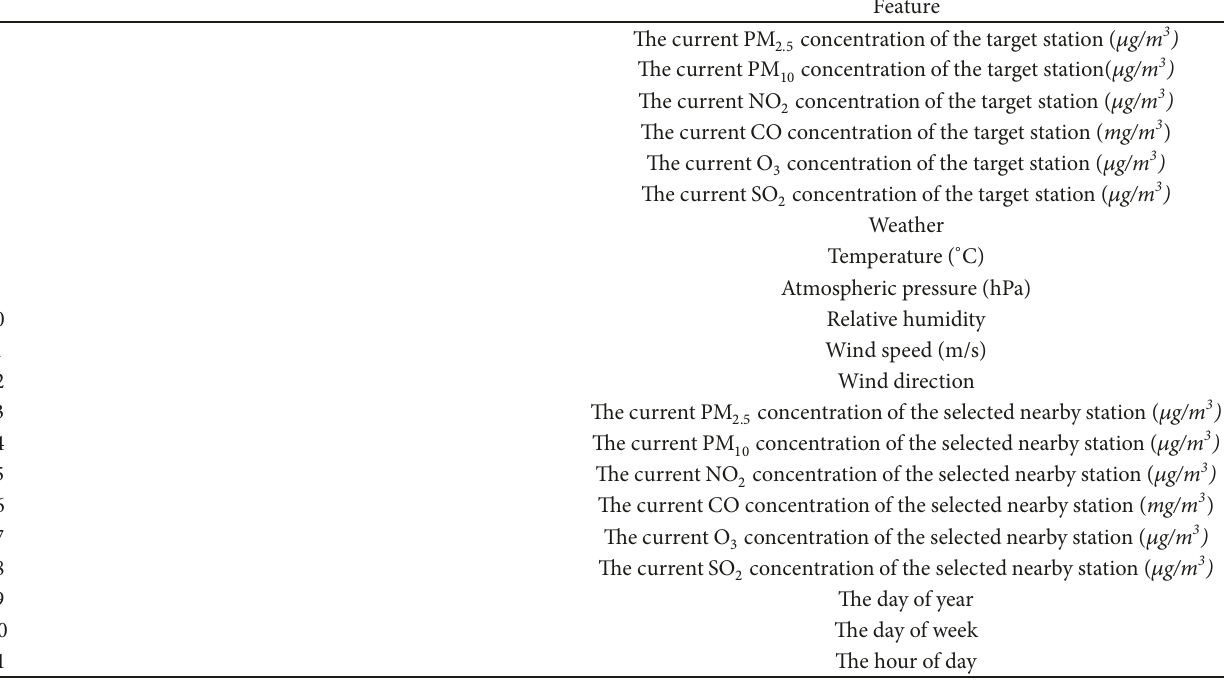
Table 1: The 21 elements in the candidate feature